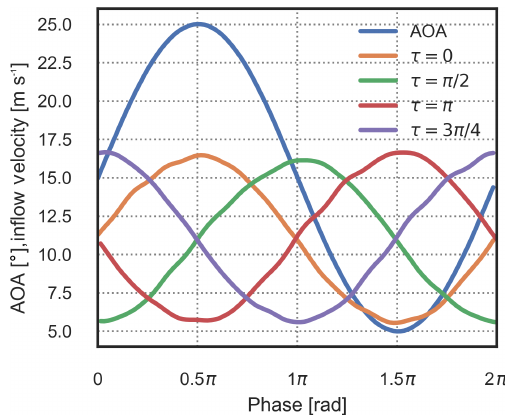
Figure 9. Inflow and angle of attack for Figs. 10 and 11.